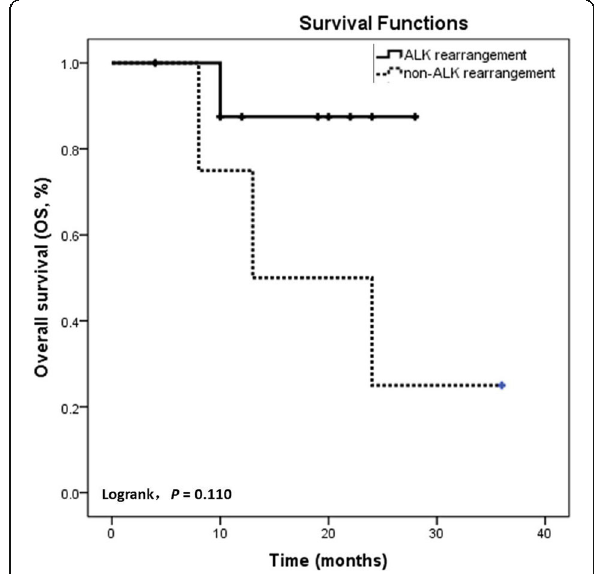
Fig. 4 Kaplan-Meier survival analysis and log-rank analysis of patients with or without ALK rearrangements. Patients with ALK rearrangement had a better prognosis than did those without ALK rearrangement, though no statistically significant difference in survival (log-rank test, P =0.110) was observed due to the small cohort. One patient who did not undergo targeted therapy for ALK rearrangement died. To some extent, ALK inhibitors are effective for these